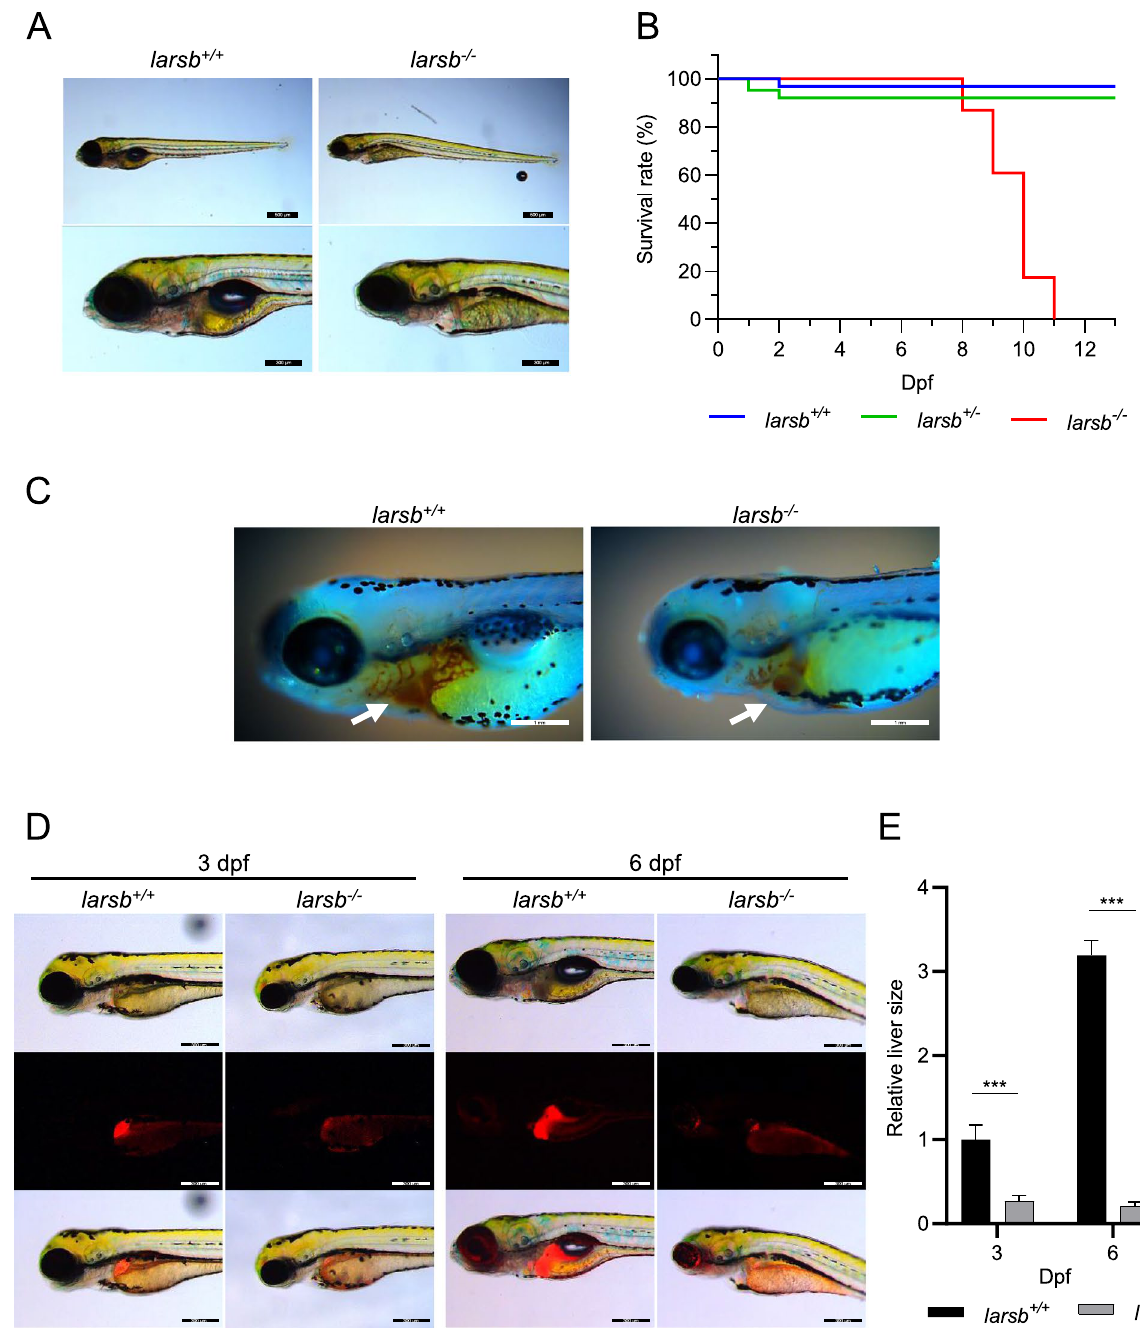
Figure 2. Larsb -knockout larvae display severe developmental phenotype and liver abnormality with early lethality. (A) Bright field lateral views of larsb + / + and larsb −/− embryos at 96 h post fertilization (hpf). Scale bar: 500 μm (top row) and 300 μm (bottom row). (B) Kaplan–Meier survival curve of larsb + / + (n = 32), larsb + /- (n = 63), and larsb −/− (n = 23) larvae. (C) Lateral views of larsb + / + and larsb −/− embryos containing haemoglobin- containing cells (white arrows) stained with o-dianisidine at 72 hpf. (D) Morphological abnormality at 3 dpf and 6 dpf in the livers of larsb −/− larvae under Tg[ fabp10 :mcherry] background. Scale bar: 300 μm. (E) Quantification of liver size in larsb −/− larvae under Tg[ fabp10 :mcherry] background (3 dpf and 6 dpf). Liver sizes were evaluated using ImageJ software version 1.52a (https:// imagej. nih. gov/ ij/). n = 5 fish/group. Error bars indicate SEM. Student’s t-test; ***P < 0.001. Statistics were calculated and the figure was produced in